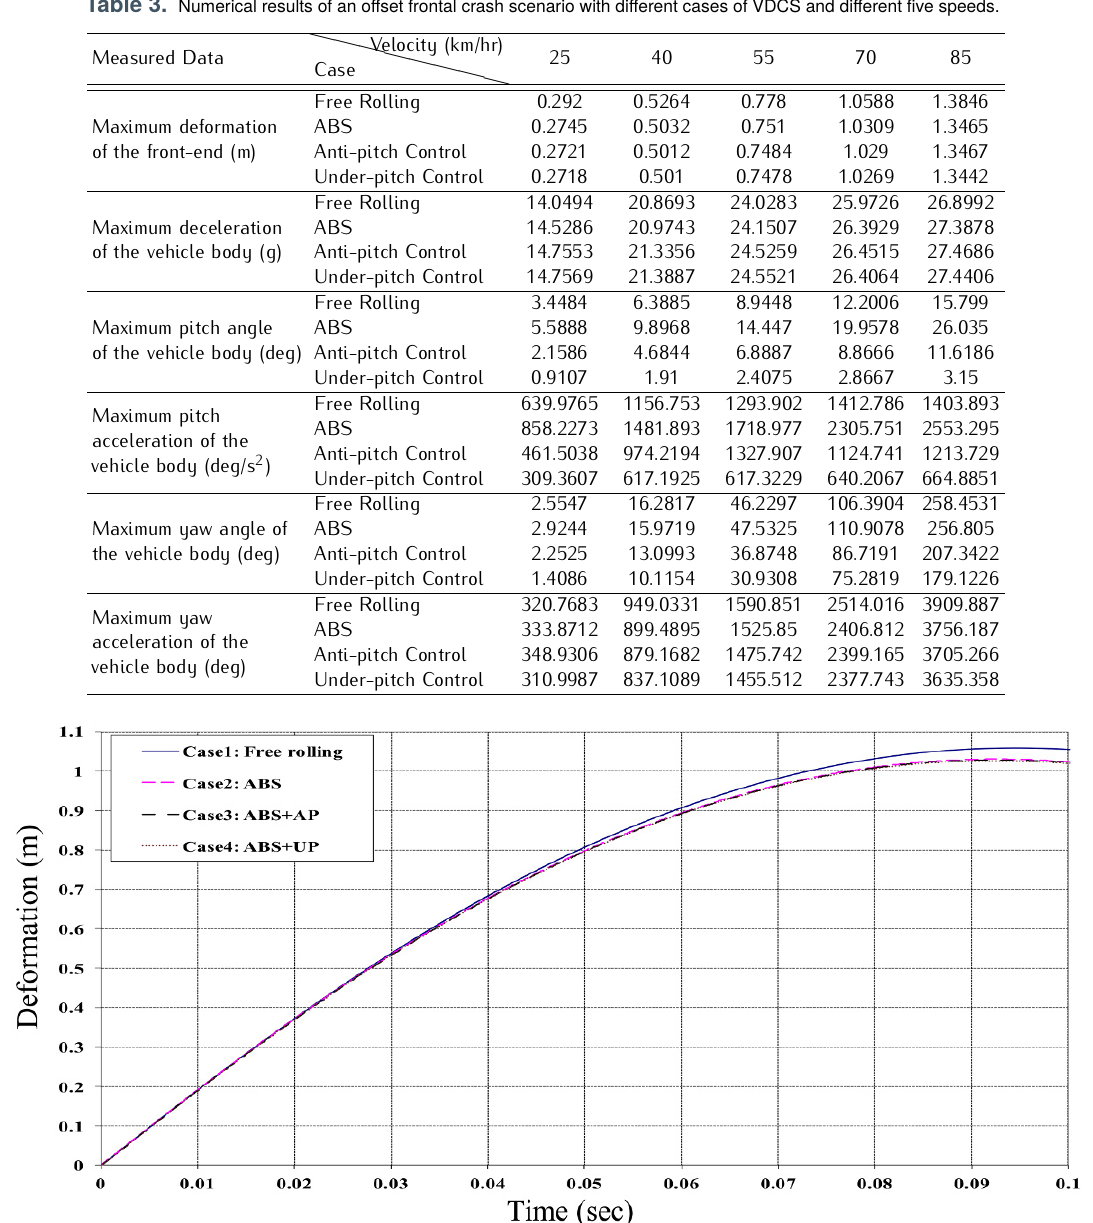
Figure 17. Time (sec) Deformation of the vehicle front-end for all cases at offset collision and speed of 70 km/hr.